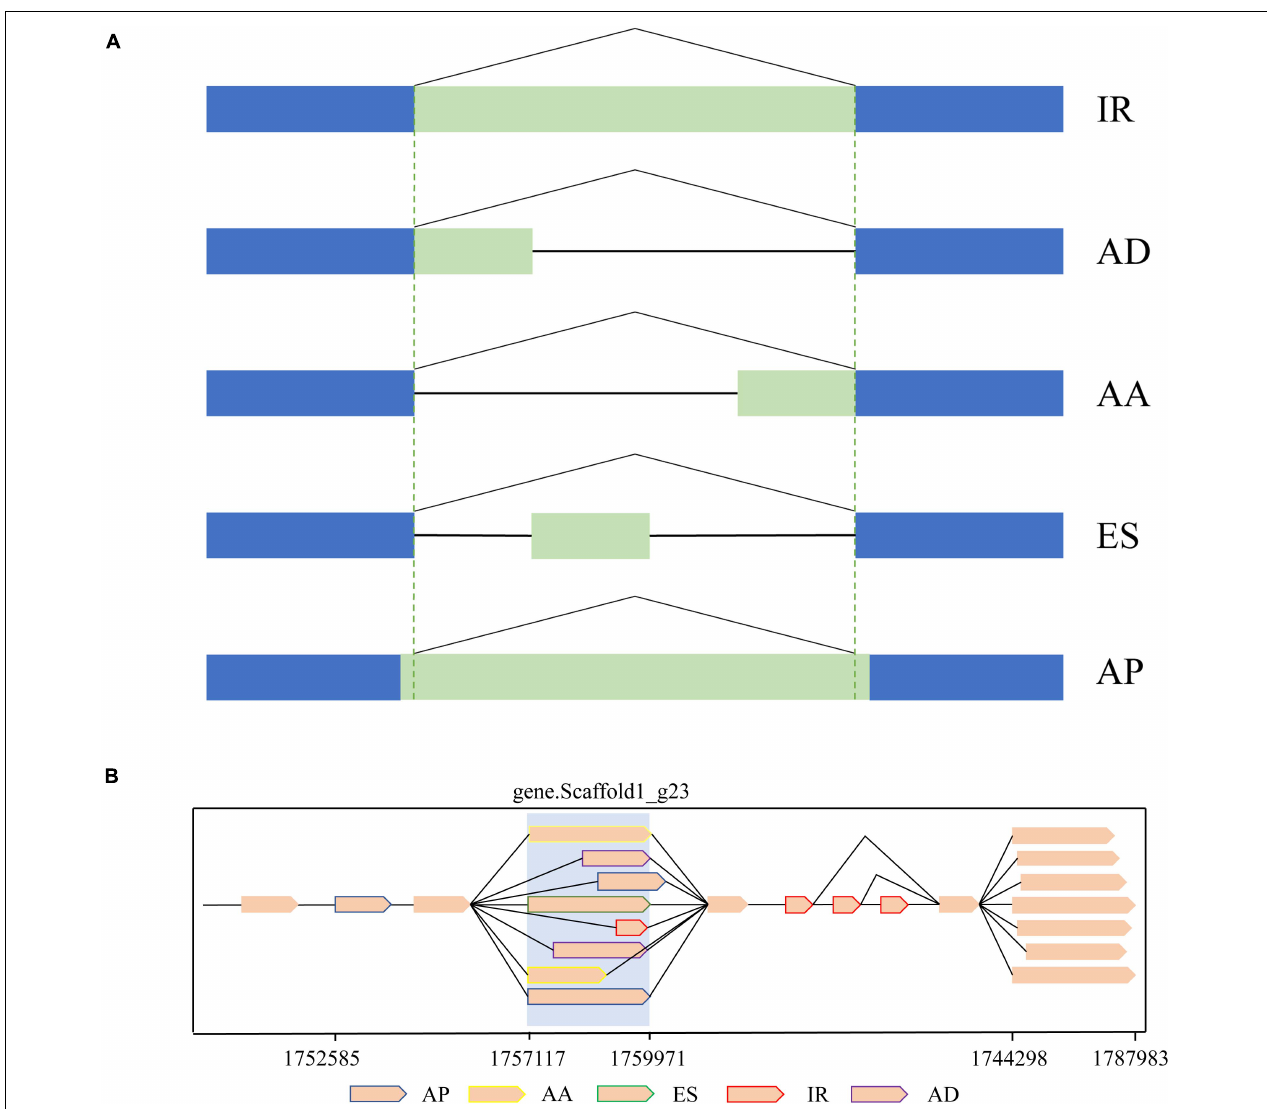
FIGURE 5 | Schematic diagram of Alternative Splicing (AS). (A) Structure of AS types classified using alternative splice. (B) Schematic illustration of alternative isoforms within the PacBio